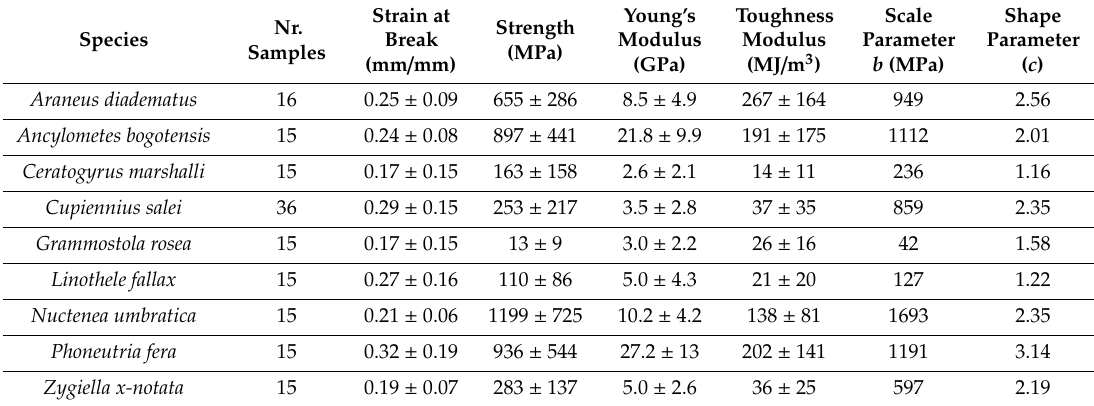
Table 1. Mechanical properties and Weibull parameters of di ff erent spider